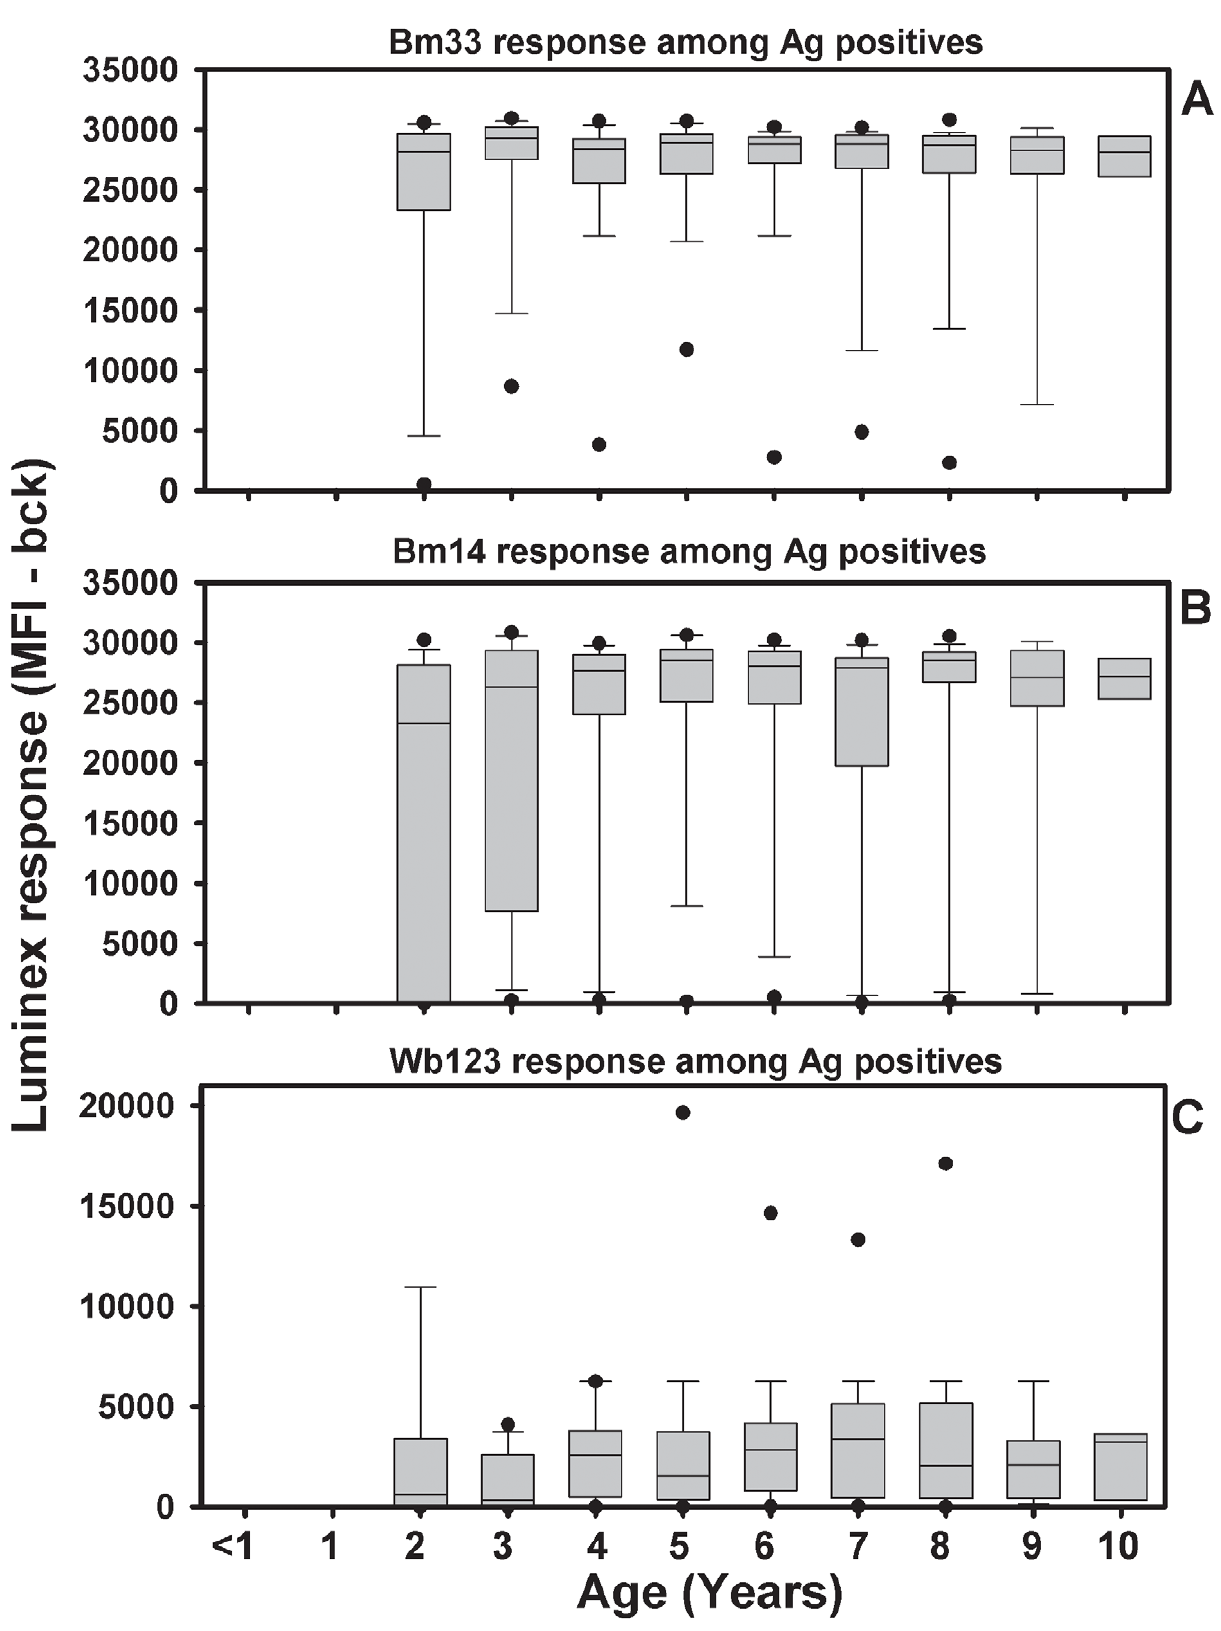
Figure 4. Quantitative changes in antibody among antigen-positive children. Shown are Bm33 (panel A), Bm14 (panel B), and Wb123 (panel C) antibody levels by age for antigen-positive children. In this plot, boxes represent the 25 th –5 th percentile with the line in the box, the median.